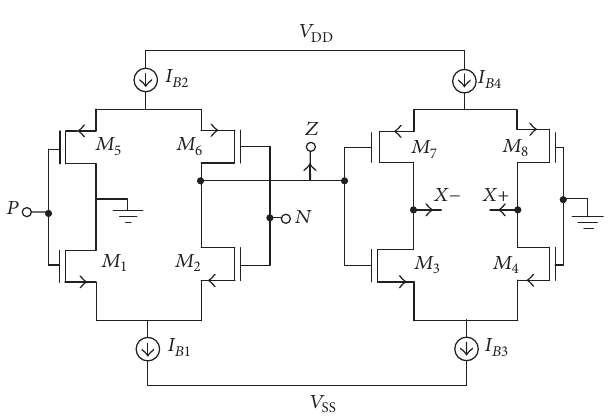
Figure 2: CMOS representation of VDTA.